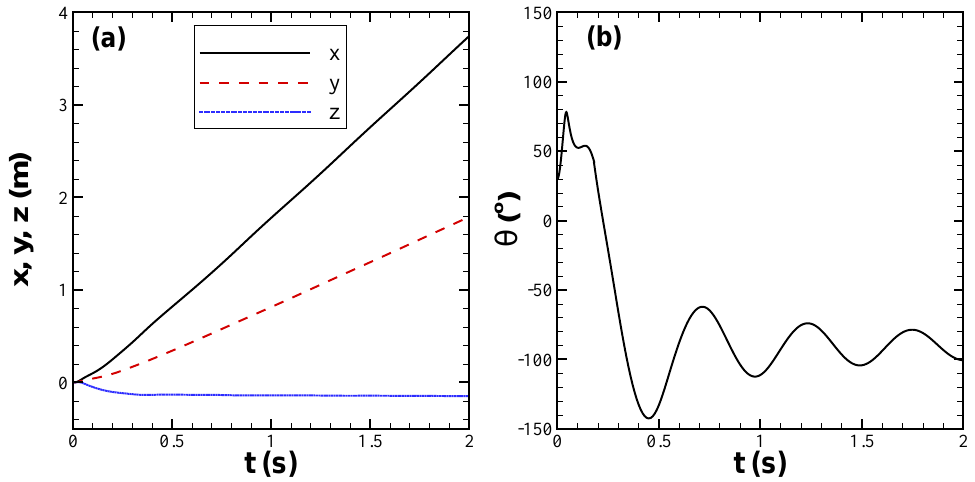
Figure 2 . Trajectory of Sensor Fish for case 1 in two-dimensional uniform flow with an offset between the mass center and the geometric center of Sensor Fish, (a) x(t), y(t), and z(t); (b) θ ( t ) . is the inertial tensor, in which ( I , I , I ) are the moments of inertia and the other components are xx yy zz usually referred to as the products of